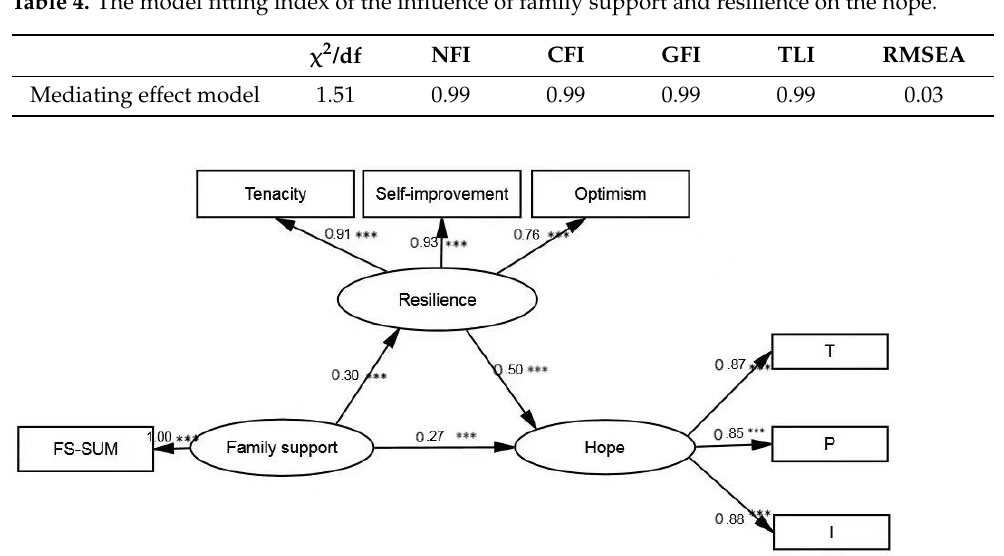
Table 4. The model fitting index of the influence of family support and resilience on the hope.